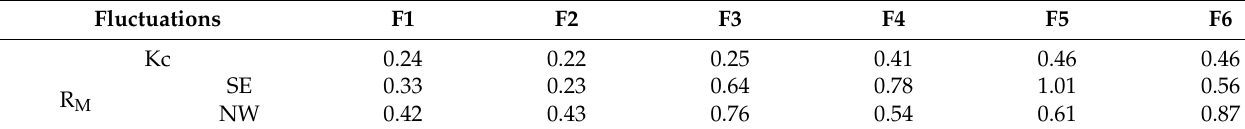
Table 13. The data of the average wind speed ratio and contour tortuosity.